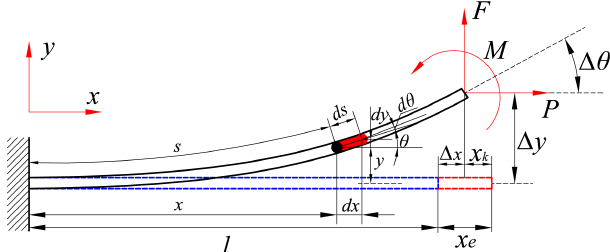
Figure 1. Deflection of a cantilever beam subject to a combined end force and